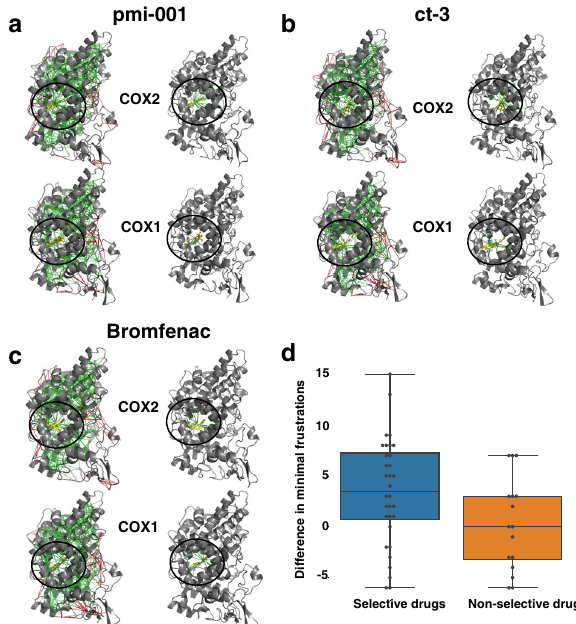
Fig. 6 Examples of localized frustration patterns in cox-inhibitor complexes. For each drug, the frustration indices are shown as calculated and shown on the left panel, and frustrations around the ligands only are shown on the right panel. pmi-001 ( a ) is a selective inhibitor for COX2. ct-3 ( b ) and bromfenac ( c ) are inhibitors without selectivity. d Box plot of the increased minimally frustrated interactions in COX2 over COX1 is shown for both the selective drugs of COX2 and non-selective Fig. 6a, pmi-001 is a selective inhibitor for COX-2. Binding pmi-